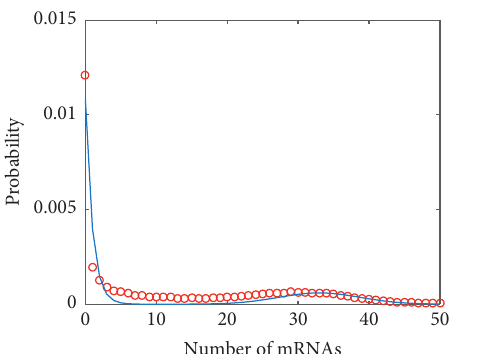
Figure 2: Comparison probability distributions between analytical (solid line) and numerical (empty circles) results, where parameter � 0 . 27 ) , ( c � 0 . 23 ) , ( c � 0 . 27 ) , ( c � 0 . 27 × 0 . 013 ) , ( c values are set as ( c 01 10 12 21 ( μ � 33 ) , ( μ � 33 × 11 ) , and ( δ � 1 ) 1 2